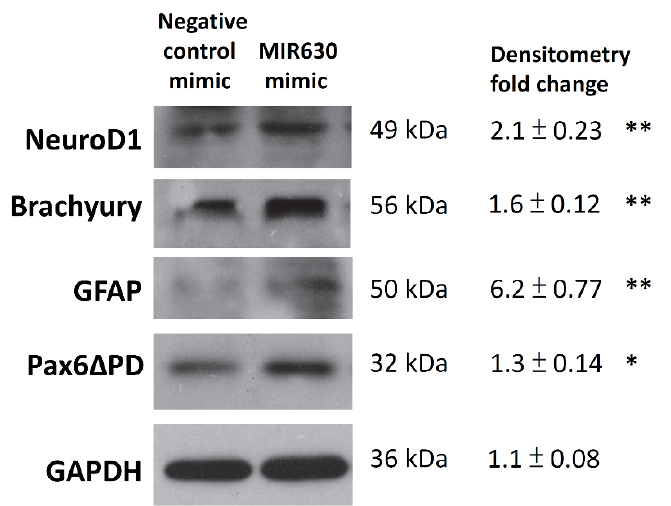
Figure 4. MIR630 mediates the expression of differentiation markers in NT2/D1 cells. NT2/D1 cells were stably transfected with either negative control miRNA mimic or MIR630 mimic for 3 days. Total cell lysates were prepared and analyzed by Western blotting with antibodies against NeuroD1, Brachyury, GFAP, Pax6, or GAPDH. To compare the relative band intensities, all immunoreactive bands were normalized to GAPDH by densitometry. The ratio in negative control miRNA-transfected cells was set to 1. Data are mean ± s.d. Two-tailed Student’s t-test was used, where * denotes p < 0.05 and ** denotes p < 0.01.